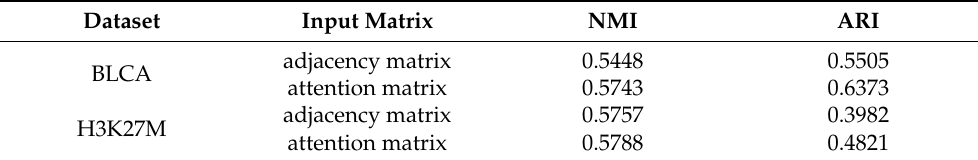
Table 5. NMI and ARI scores of the Hierarchical Clustering applied on attention and adjacency matrices.